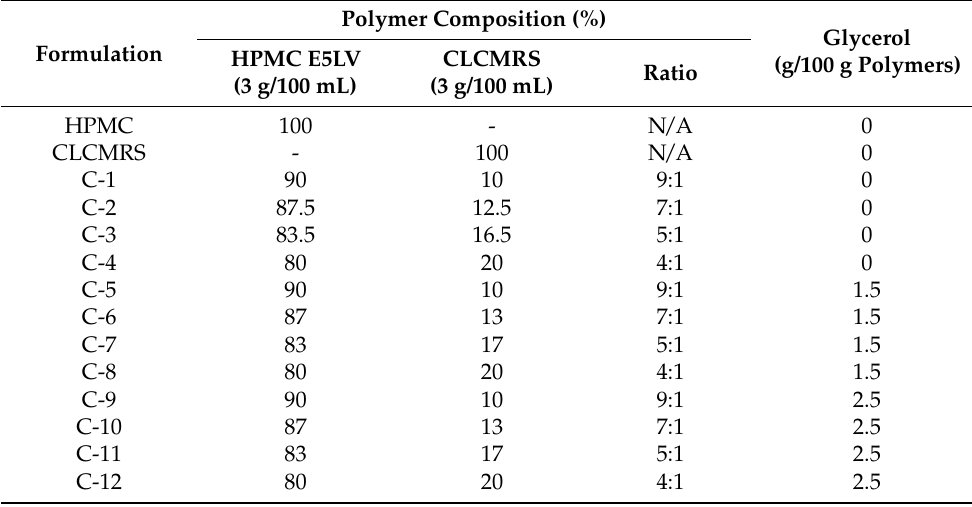
Table 1. Composition of HPMC-CMRS composite